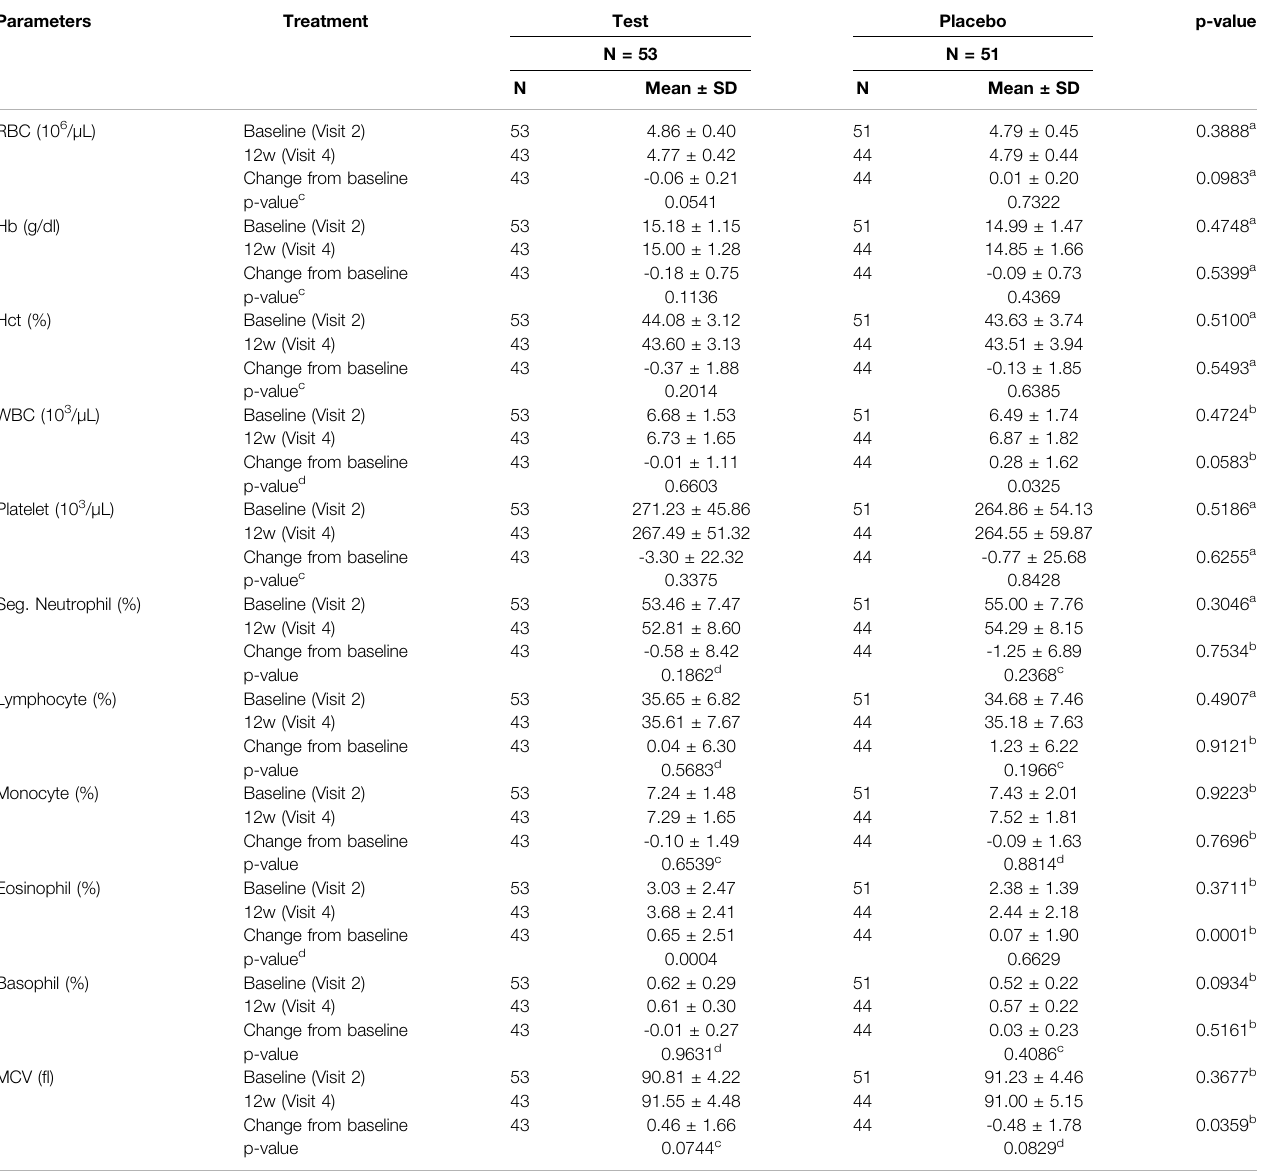
TABLE 9 | The association between the blood parameters and Golden- Antrodia Camphorata consumption (Safety set). Parameters